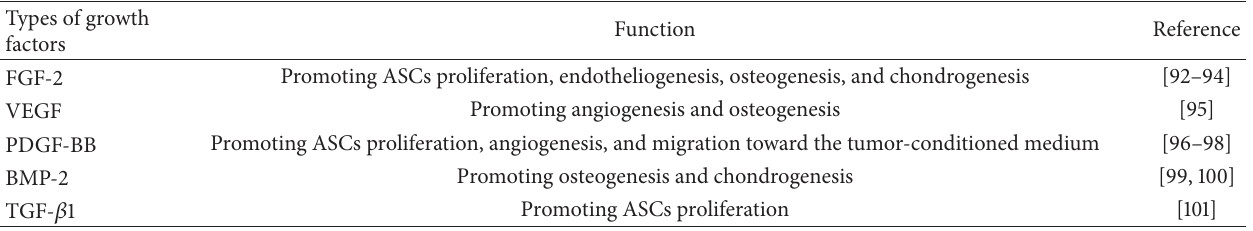
Table 3: The effect of growth factors to ASCs.